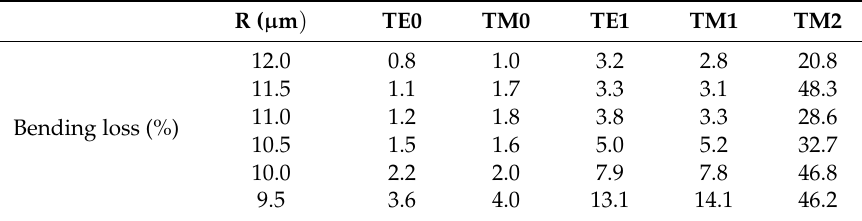
Table 1. Bending loss of each mode according to the radius.